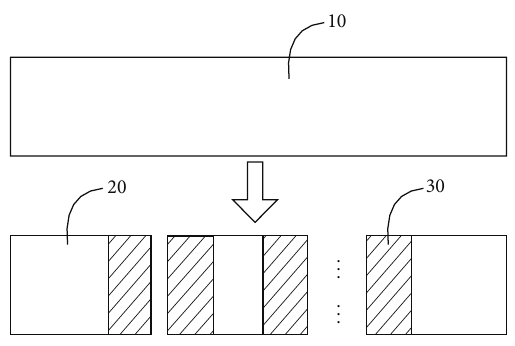
Figure 2: Schematic diagram of traditional data